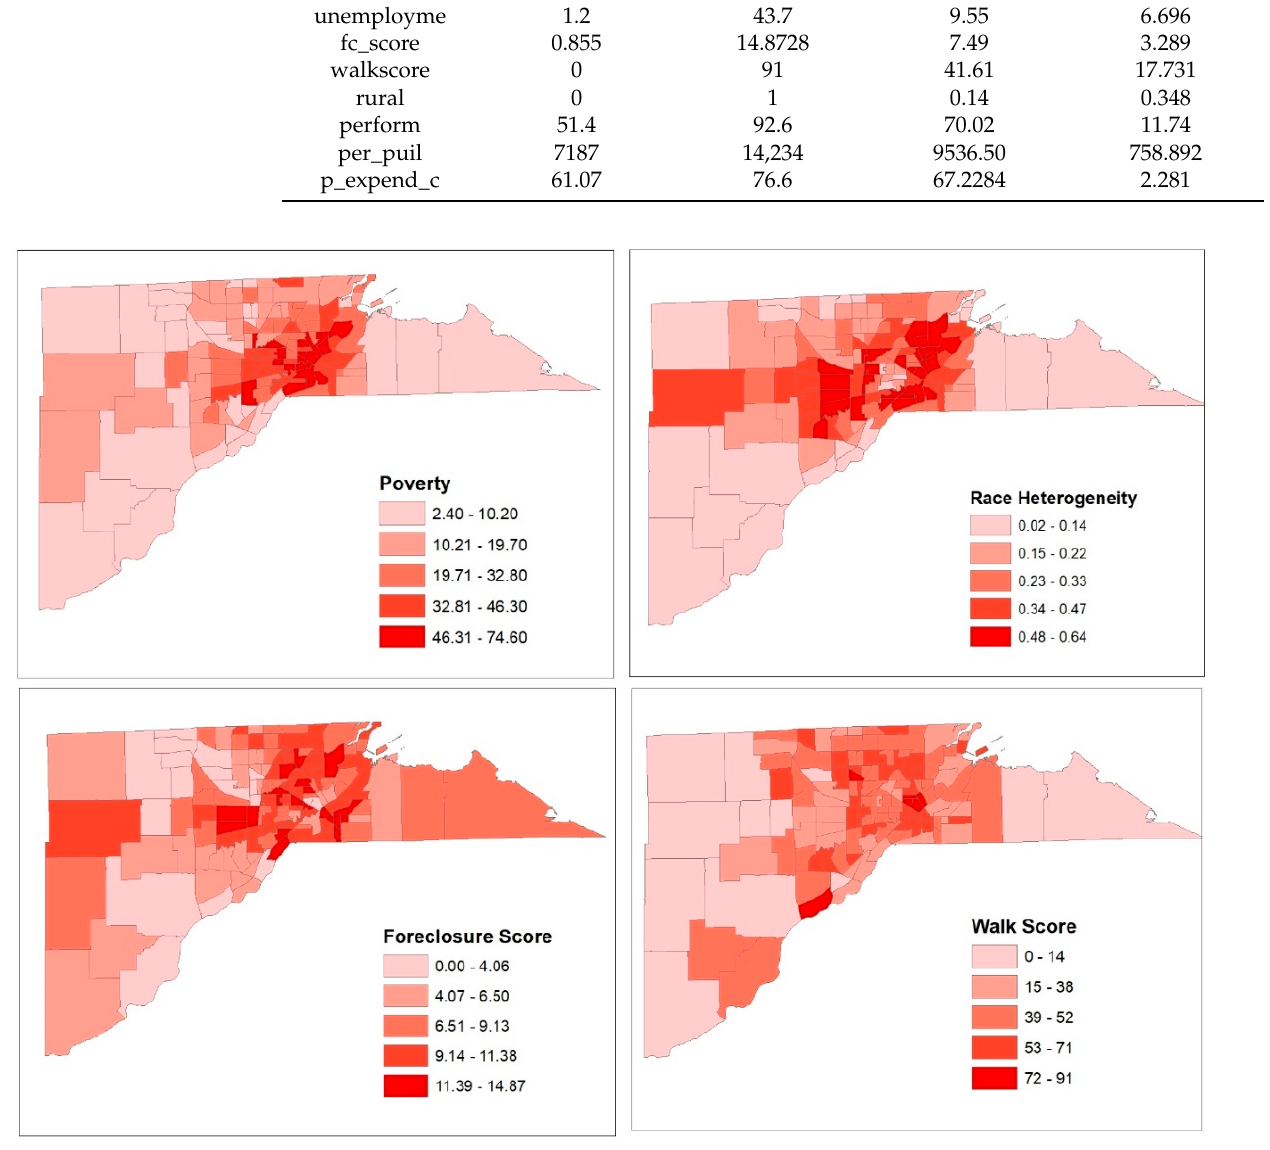
Table 5. Basic statistics of independent variables.